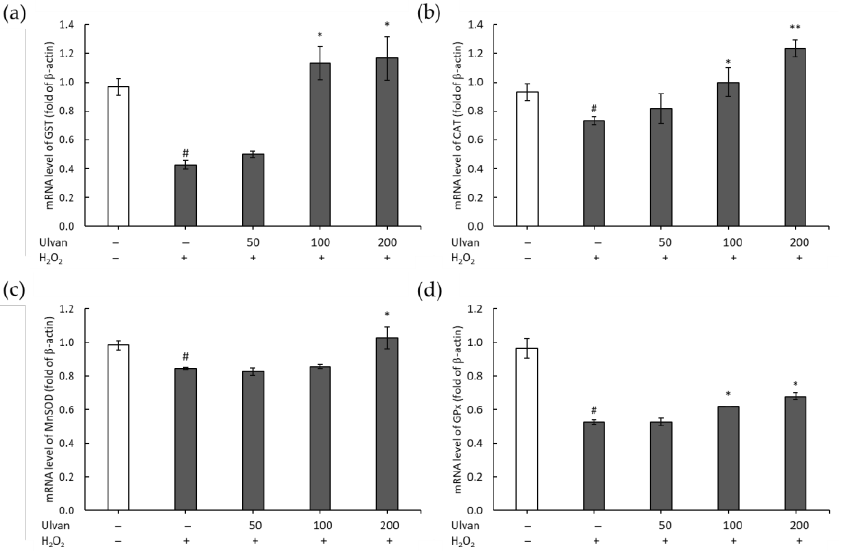
Figure 6. Effects of ulvan (µg/mL) on the expression of the antioxidant genes GST ( a ), CAT ( b ), MnSOD ( c ), GPx ( d ) in 264.7 cells treated with H 2 O 2 . The results are presented as means ± SD ( n = 3); * p < 0.05 and ** p < 0.01 vs H 2 O 2 treatment; # p < 0.05 compared with the control group.